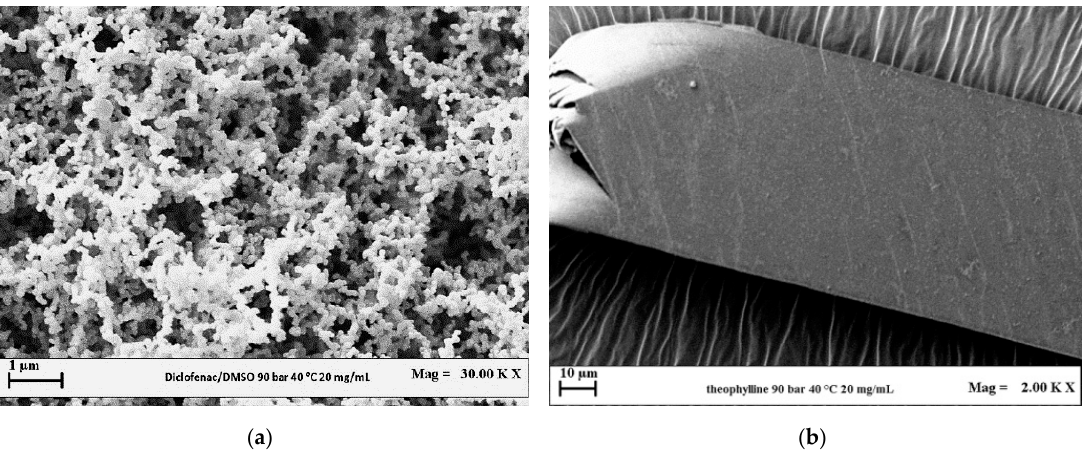
Figure 4. FESEM images of the drugs precipitated from DMSO at 9 MPa, 40 °C and 20 mg/mL. ( a ) DICLO; ( b ) THEOP.